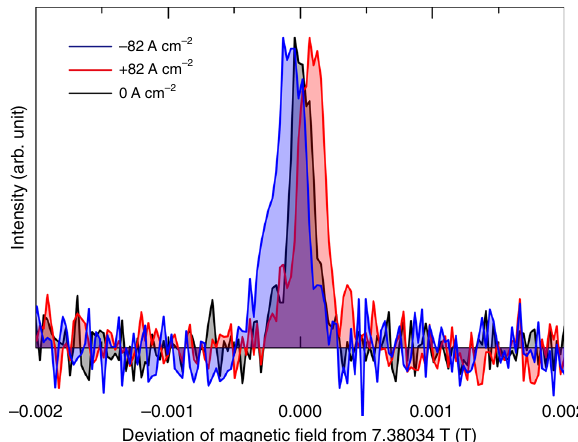
Deviation of magnetic field from 7.38034 T (T) Fig. 2 Pulse-current dependence of line H in 125 Te-NMR spectrum. The NMR spectra are shown as a function of deviation of magnetic fi eld felt by the 125 Te nuclei (see Methods) from 7.38034 T. The black, red, and blue lines correspond to data obtained under pulsed electric current densities of 0, + 82, and − 82 A cm − 2 ,